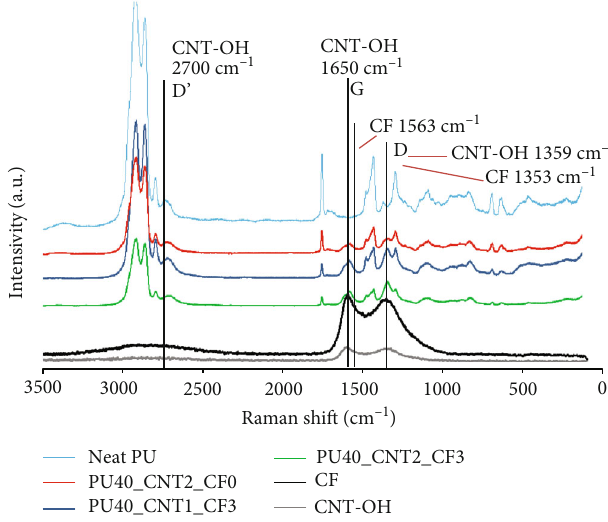
Figure 7: Raman spectra of neat PU, carbon components, and